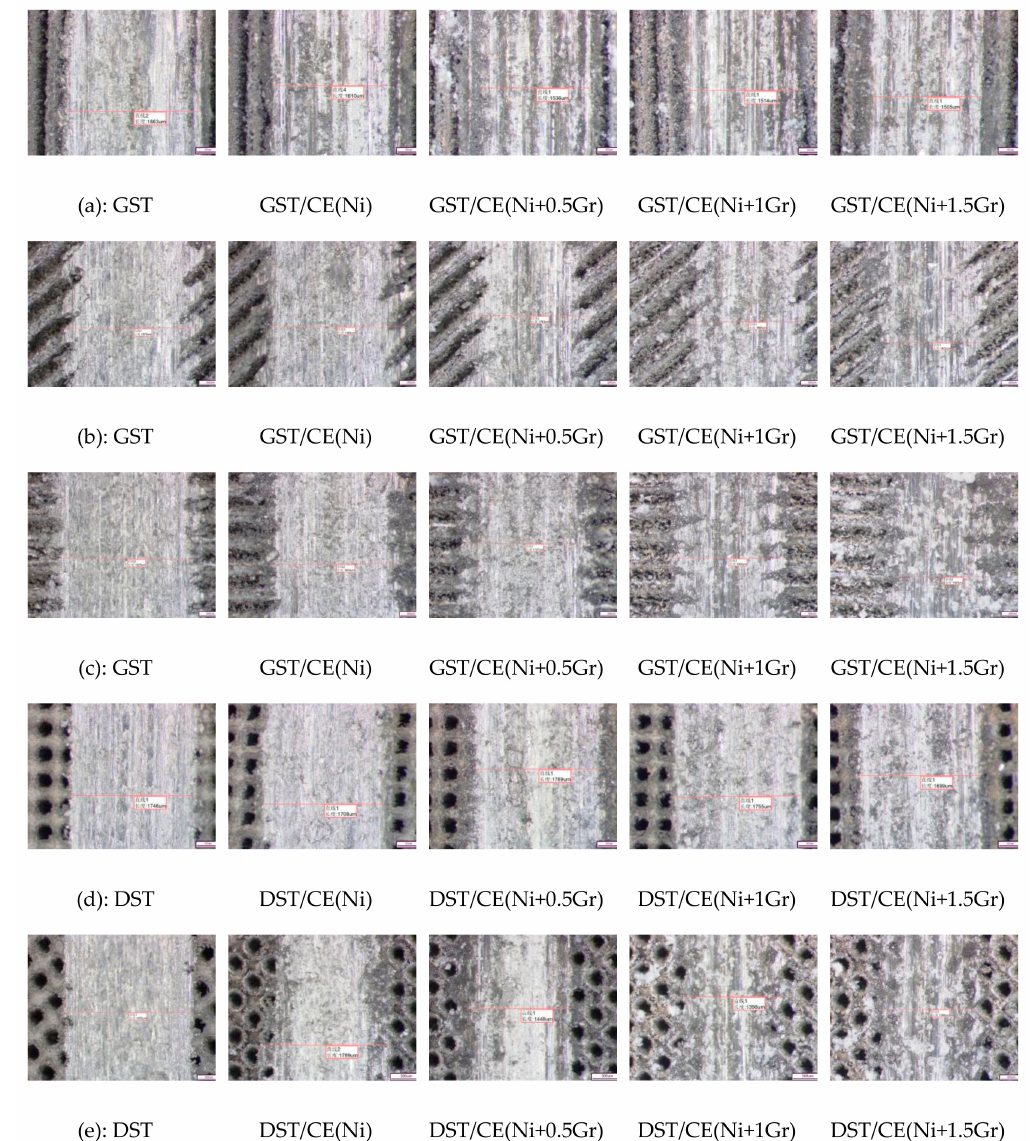
Figure 12. Micrographs of worn trace for all the textured surface of aluminum plate. ( a – c ) the worn trace width of GST at 0 ◦ , 45 ◦ and 90 ◦ , respectively. ( d ) and ( e ) the worn trace width of DST at 0 ◦ and 45 ◦ ,